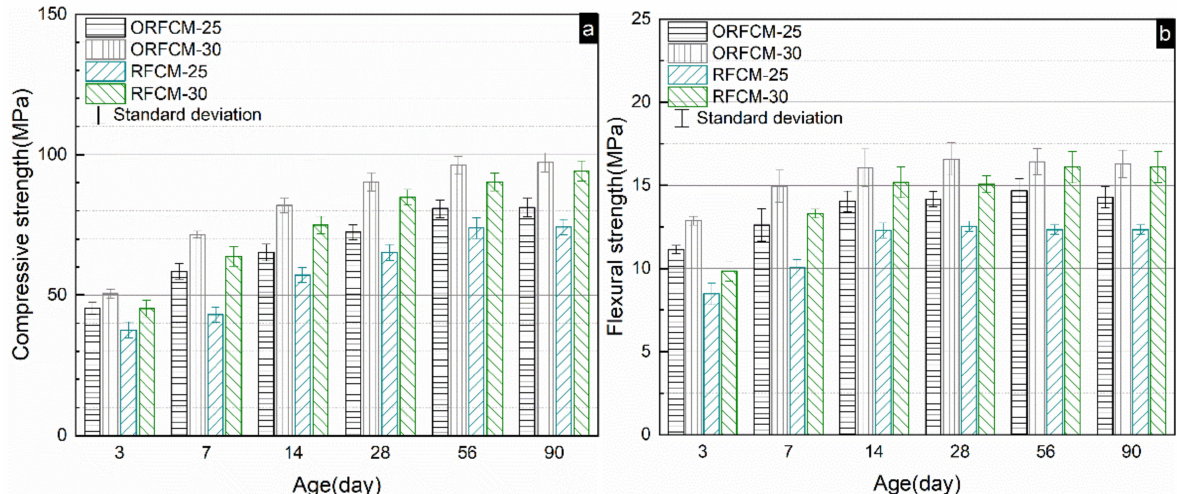
Figure 7. Compressive ( a ) and flexural ( b ) strength of optimized and non-optimized limestone-ultrafine Portland cement reverse filling cementitious system.